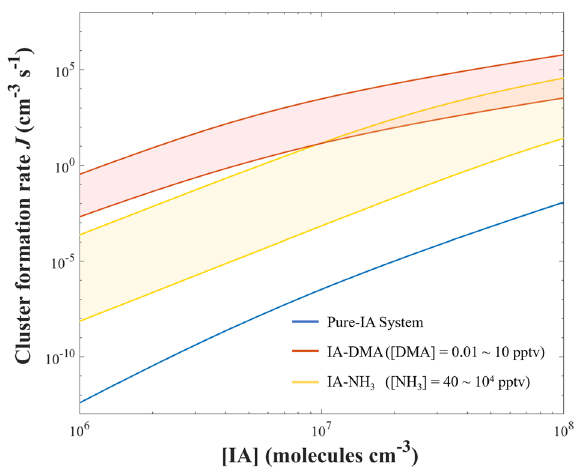
Fig. 4 Simulated cluster formation rates J (cm − 3 s − 1 ). J as a function of IA concentration of Pure-IA, IA-DMA, and IA-NH 3 system at T = 278 K and CS = 2.0 × 10 − 3 s − 1